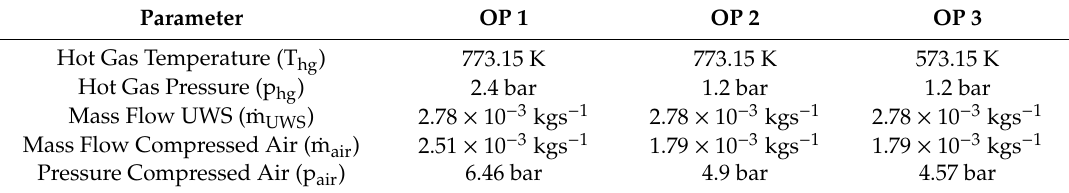
Table 4. Operating conditions of the hot gas test bench for the three selected operating